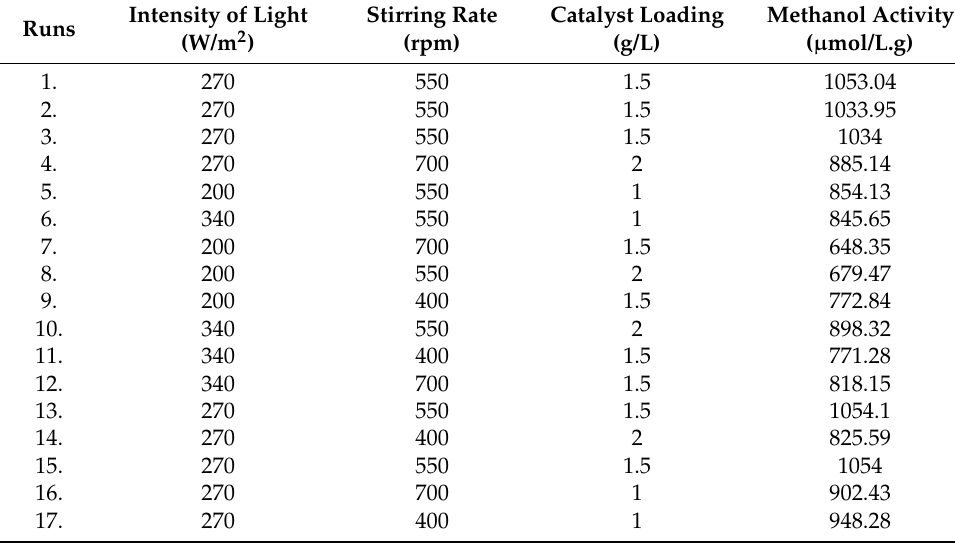
Table 3. Experimental runs during